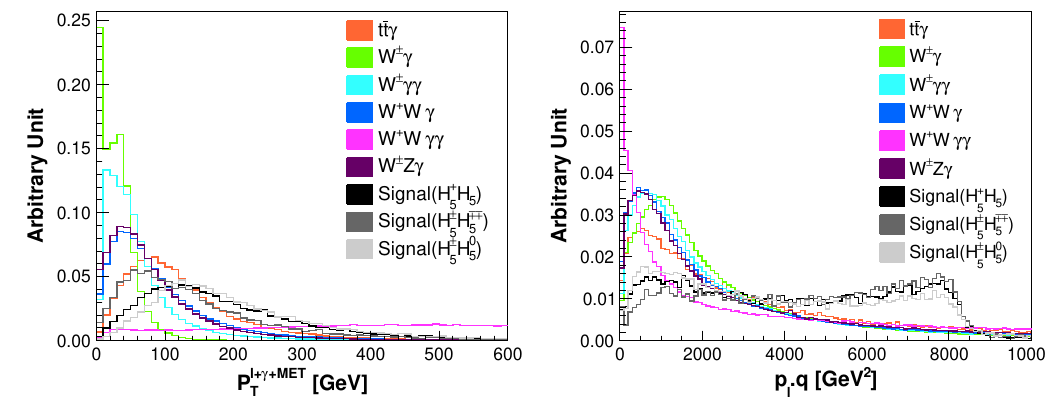
Figure 6 . Normalized distributions of p ‘ + (cid:13) + =E T q (right) for m 5 = 150 GeV for the (left) and p ‘ T (cid:1) q at the kinematic endpoint at signal and background processes. The characteristic peak in p ‘ (cid:1) m 2 q distribution from the ideal ( m 2 ) = 2 is visible in the right plot. The deviation of the p ‘ 5 (cid:0) W (cid:1) q is mainly due to mis-pairing of the lepton and parabolic shape at low p ‘ (cid:1)